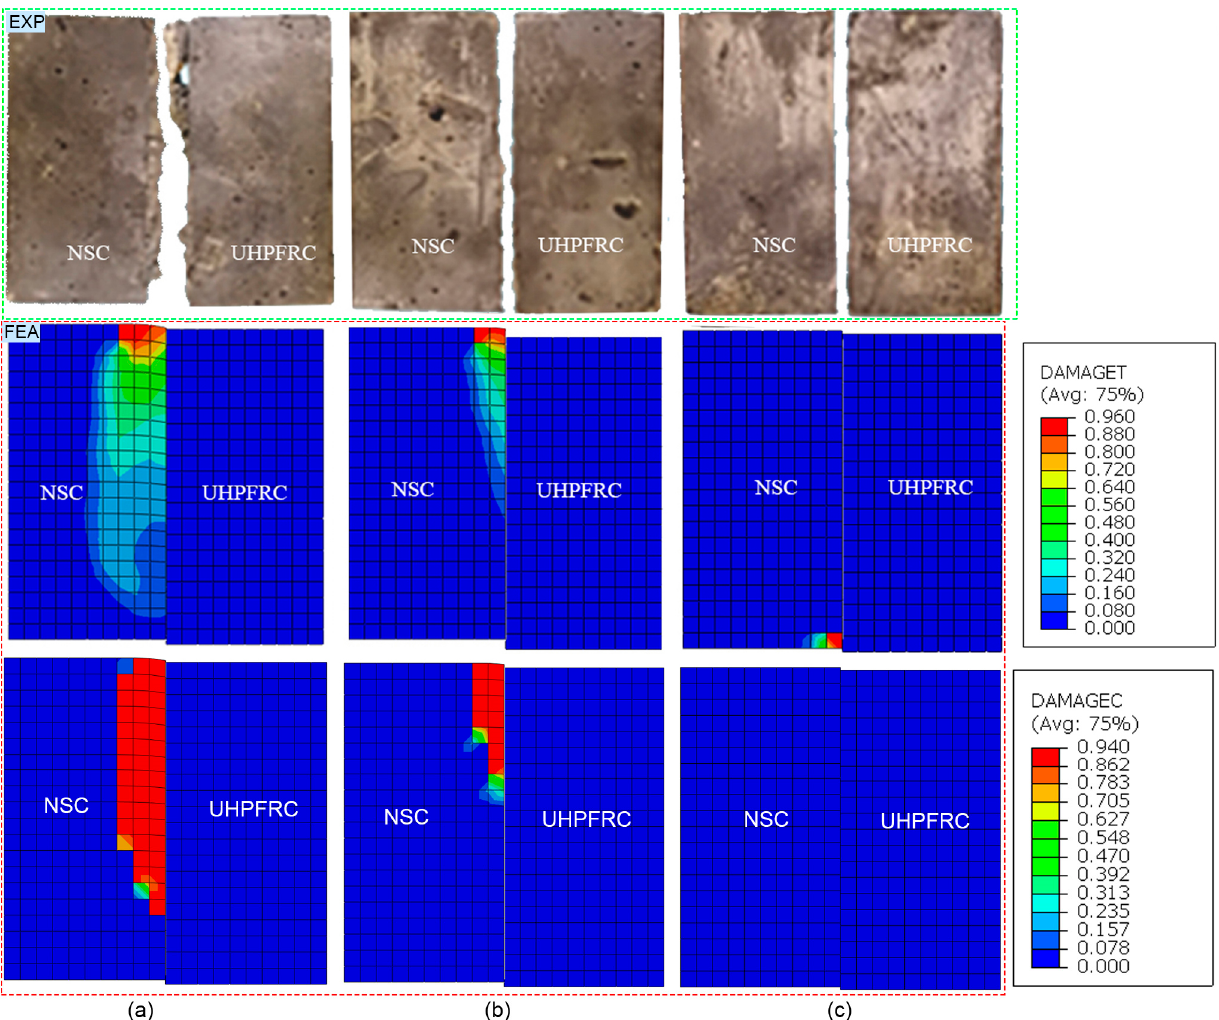
Figure 11. Comparison of the failure of the NSC-UHPFRC specimens between the EXP [20] and simulations for three distinct surface types in the shear test: ( a ) a rough surface; ( b ) a mid-rough surface; and ( c ) a smooth surface.